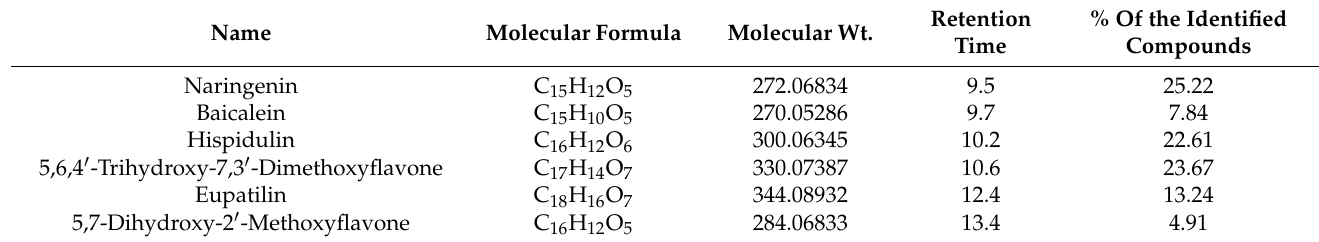
Table 2. Major compounds identified in ethyl acetate extract of A. citrodora using LC-MS .